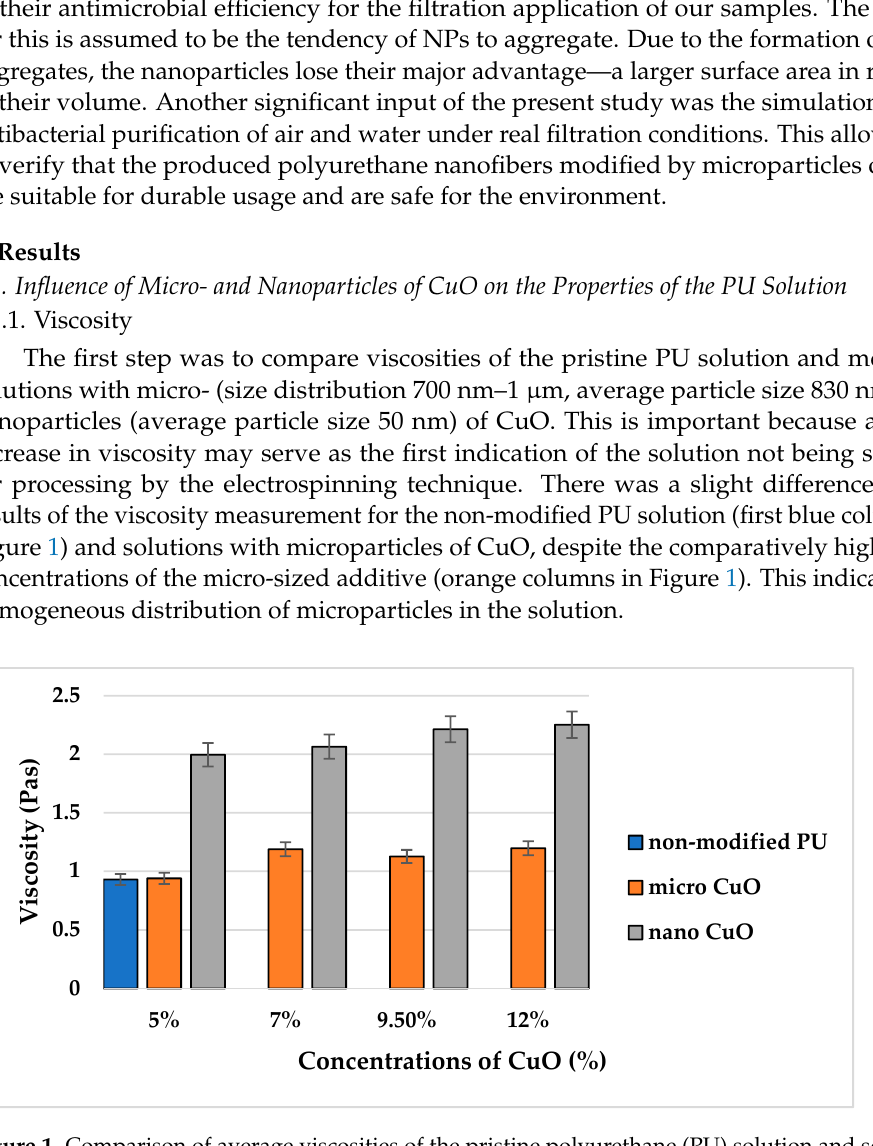
Figure 1. Comparison of average viscosities of the pristine polyurethane (PU) solution and solutions with micro- and nanoparticles of CuO.